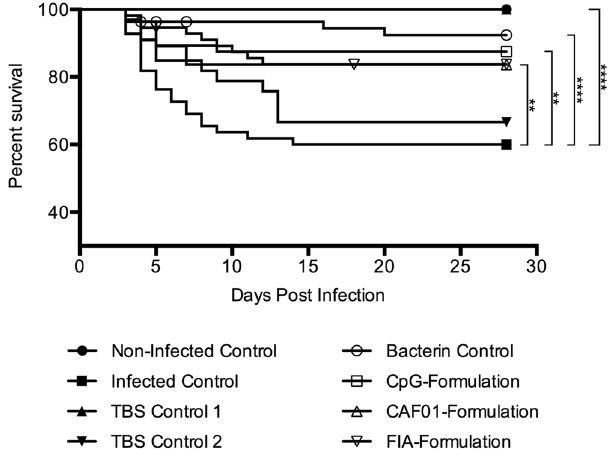
Figure 5. Results from experimental infection experiment. Methodology, calculations and statistical methods are described in material and methods section, as well as in the results section. Each graph is indicated by a symbol at 28 days post infection. Symbols prior to this indicate censored individuals (see materials and methods section). Asterisks show statistically significant differences between groups and denote: * P < 0.05, ** P < 0.01, *** P < 0.001 and **** P < 0.0001.